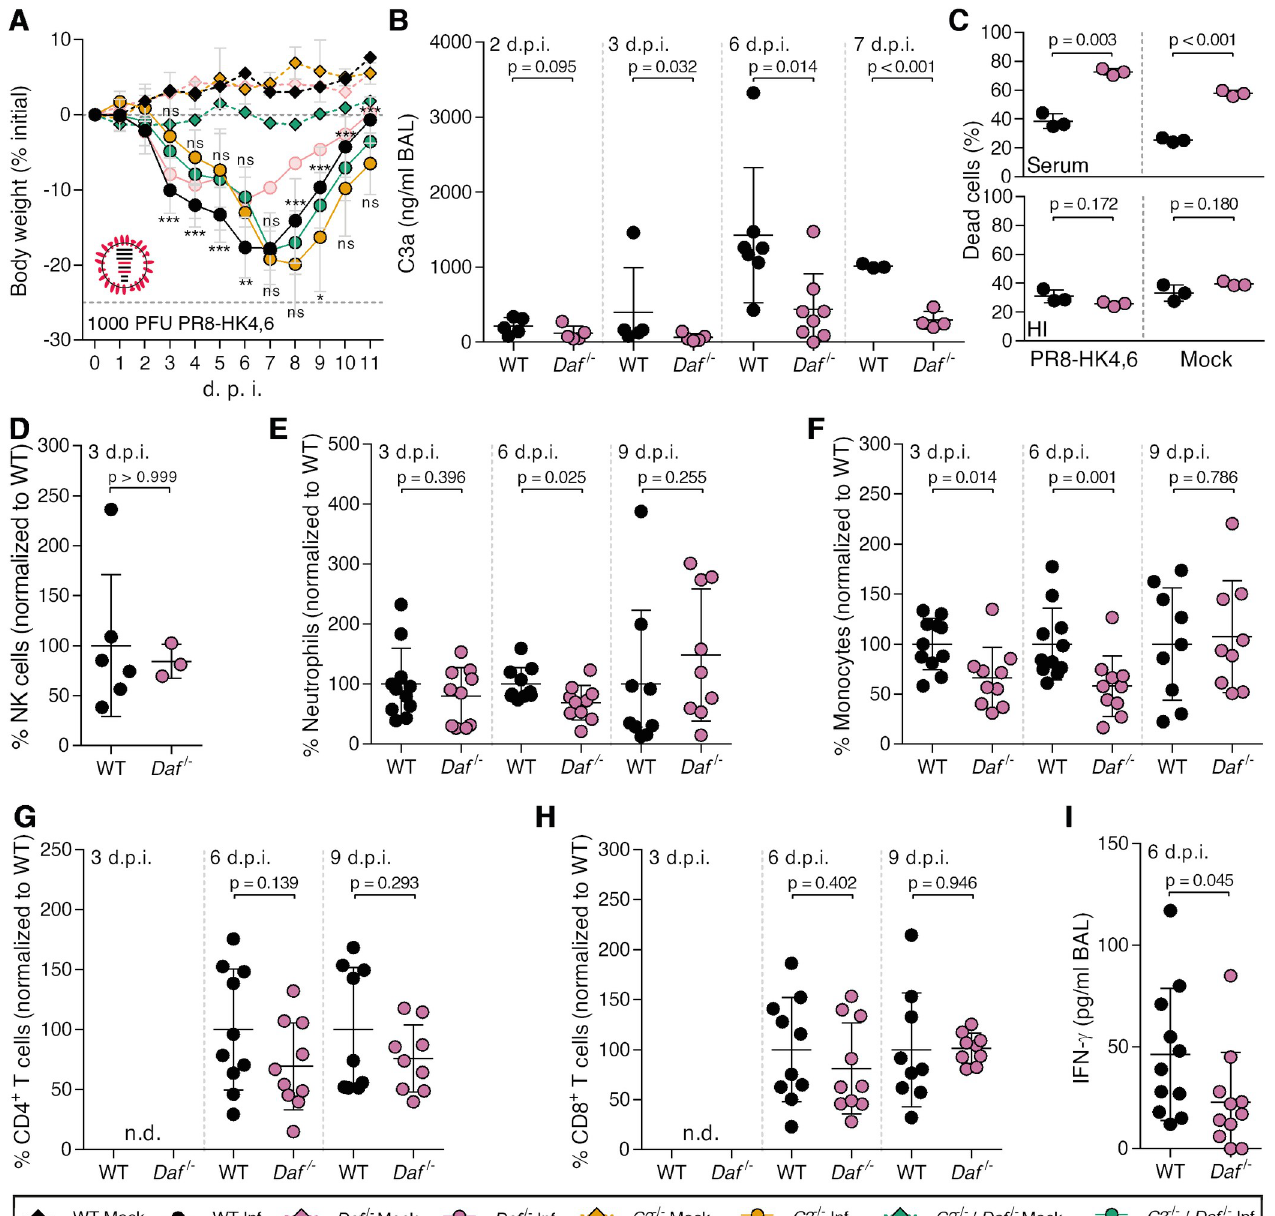
Fig 4. Daf -/- mice have reduced complement activation and recruitment of innate immune cells. A: Bodyweight loss of C57BL/6J WT, Daf -/- , C3 -/- or C3 -/- / Daf -/- mice infected with 1000 PFU of A/X-31 (PR8-HK4,6) (Inf n = 10, n = 10, n = 6 and n = 10; mock n = 9, n = 4 n = 5 and n = 7 for WT, Daf -/- C3 -/- and C3 -/- / Daf -/- respectively). Results are expressed as mean ± sd. B : C3a levels in BALs of C57BL/6J WT or Daf -/- mice 2 (n = 5 per group), 3 (n = 5 per group), 6 (WT n = 7; Daf -/- n = 8) and 7 (WT n = 3; Daf -/- n = 4) d.p.i. with 1000 PFU of PR8-HK4,6. Results are expressed as mean ± sd. C: Cell death of primary lung cells derived from WT or Daf -/- mice infected or mock-infected with PR8-HK4,6 and treated with serum. Results are expressed as mean ± sd from 3 replicates from 2 independent experiments. D, E, F, G, H : Analysis of NK cells ( D ), neutrophils ( E ) monocytes ( F ) CD4 + T cells ( G ) and CD8 + T ( H ) cells levels in BALs of WT or Daf -/- mice infected with 1000 PFU PR8-HK4,6. Samples were collected at 3 d.p.i. ( D , n = 6 and n = 3; E—H , n = 11 and n = 10 for WT and Daf -/- respectively), 6 d.p.i. (n = 10 per group) and 9 d.p.i. (n = 9 per group). Samples with non detectable cell levels are noted as n.d.. K : IFN- γ levels in BALs of WT or Daf -/- mice, 6 d.p.i. with 1000 PFU PR8-HK4,6 (n = 10 per group). Results are expressed as mean ± sd from at least 2 independent experiments. A representative experiment with absolute values can be found in S3A–S3D Fig. Statistical analysis detailed in materials and methods.